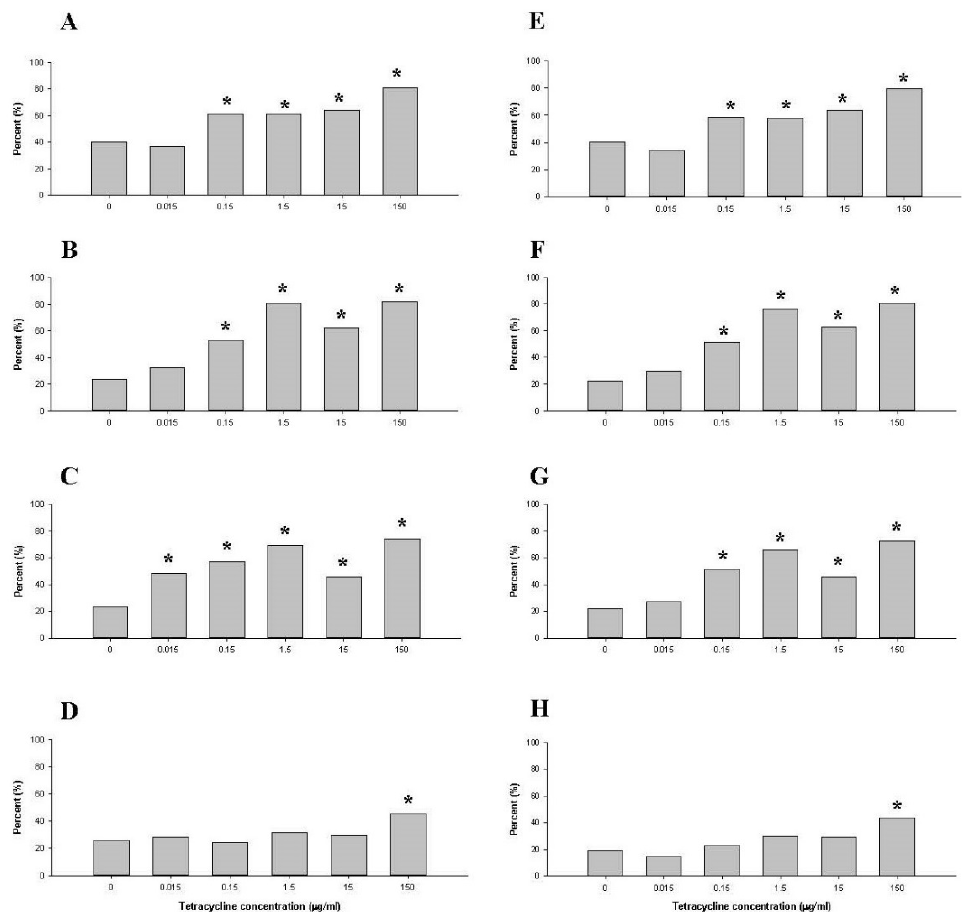
Figure 5. Comparison of percentage of four tetracycline resistance genes ( tetB , tetD , tetQ , and tetW ) as quantified by qRT-PCR in the family Enterobacteriaceae ( A – D ) and the genus Escherichia ( E – H ) in controls (no treatment) and tetracycline-treated samples after 7 days. tetB : ( A , E ), tetD : ( B , F ), tetQ : ( C , G ), tetW : ( D , E ). Quantification by qRT-PCR was performed in triplicate. Error bars indicate standard deviations. * indicates statistically significant differences from control ( p < 0.05).